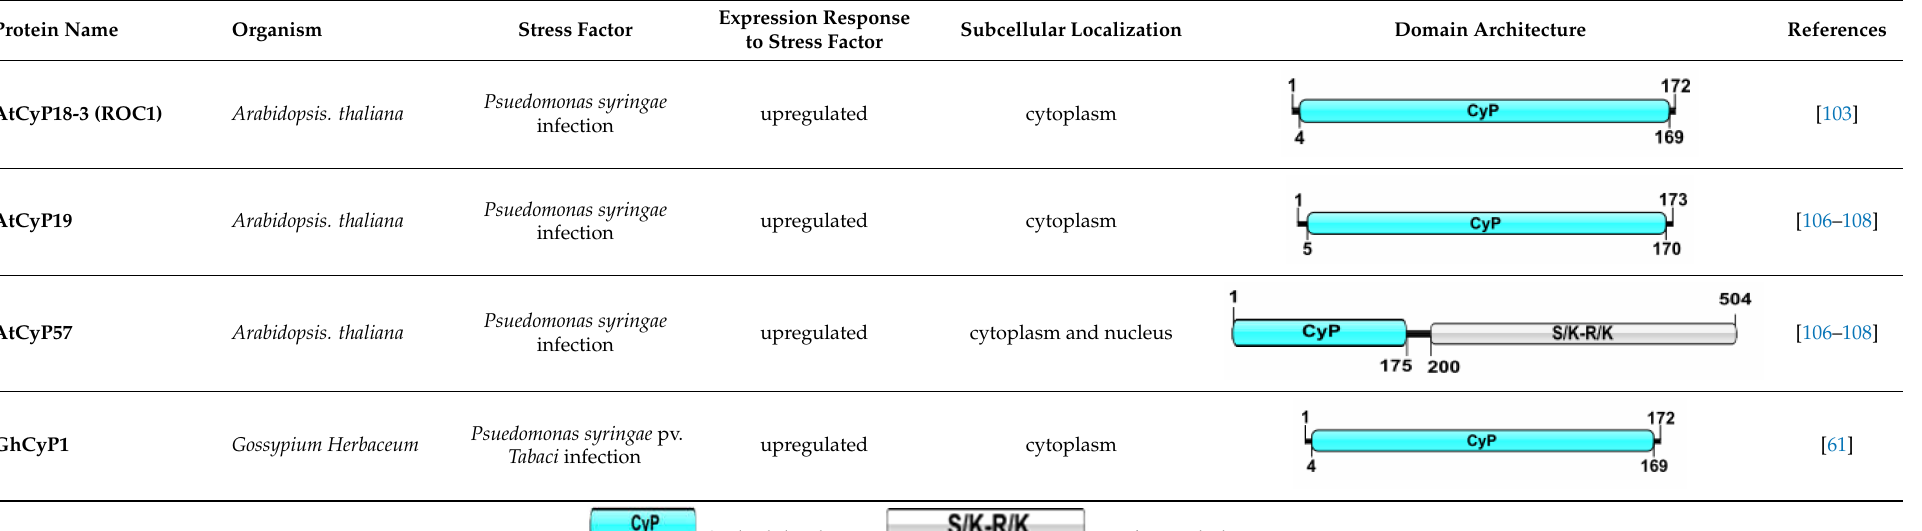
Table 2. Plant–microbe responsive cyclophilins. The domain architecture diagrams were prepared using IBS software